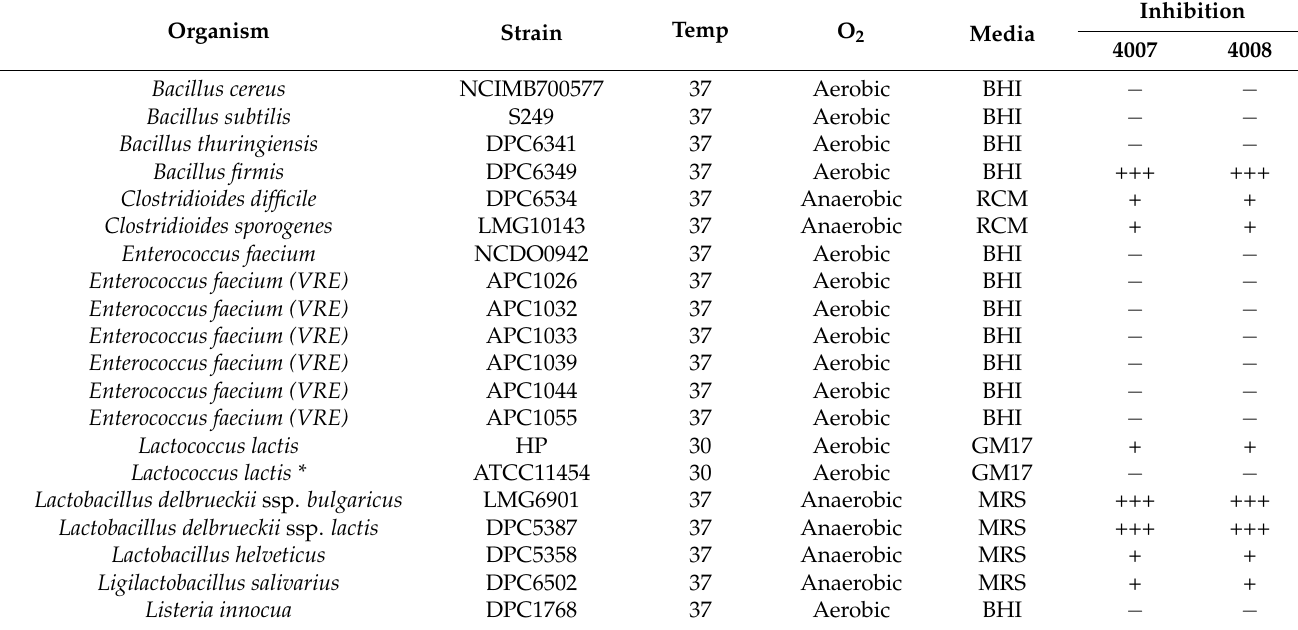
Table 2. Spectrum of inhibition of nisin E producers S. equinus APC4007 and APC4008 against bacterial strains, as determined by a deferred antagonism